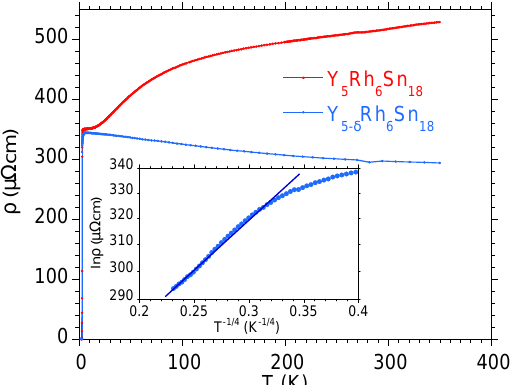
Figure 6. Electrical resistivity ρ ( T ) for stoichiometric Y 5 Rh 6 Sn 18 (red points) and off-stoichiometric Y 5 − δ Rh 6 Sn 18 (blue points) samples ( δ = 0.4 ± 0.11). Inset displays the resistivity data for Y 5 − δ Rh 6 Sn 18 in coordinates ln ρ = f ( T − 1/4 ) . The linear ln ρ vs. T − 1/4 behaviour is observed between ∼ 100 K and 350 K.